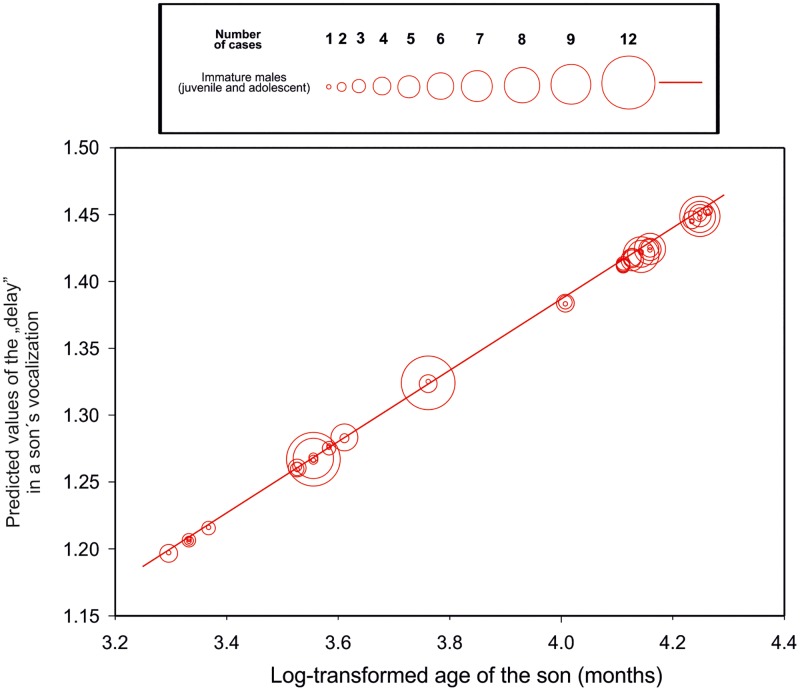
Predicted values of the delay in temporal synchrony of great calls emitted by an adult female and her son plotted against log-transformed age of the son.